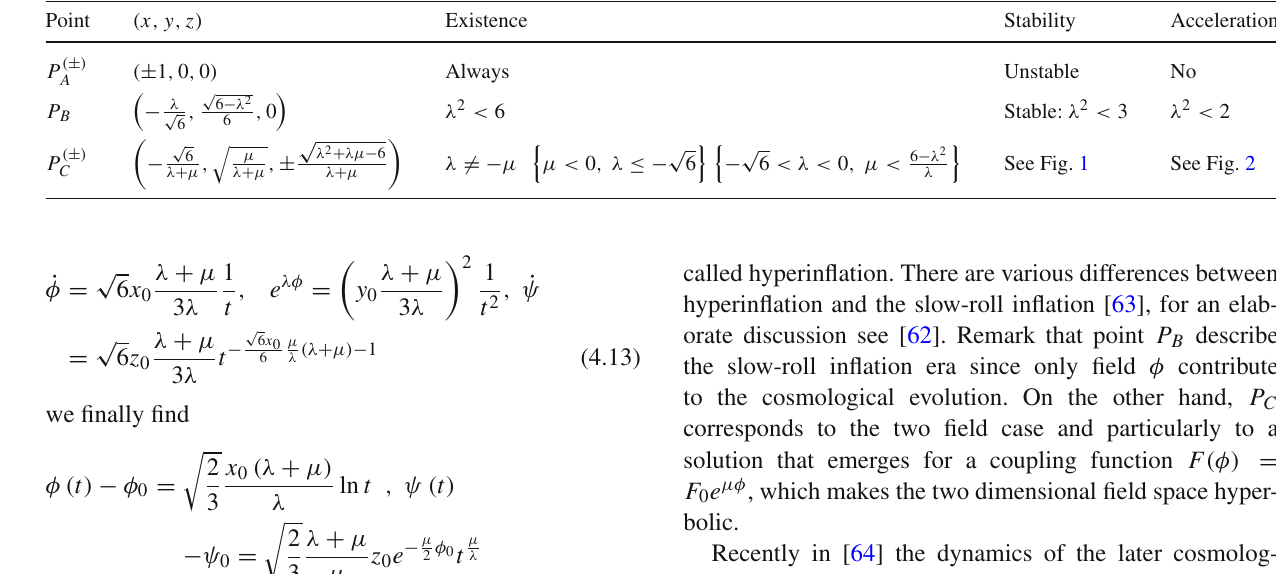
Fig. 2 Phase space diagram for the dynamical system (4.3)–(4.5) for two different set of the free parameters λ and μ . Left figure is for (λ,μ) = (λ,μ) = ( − 3 , − 4 ) and points P ± ( − 1 , 2 ) where point P are the attractors of the dynamical system B is the unique attractor while right figure is for C Table 2 Critical points of the dynamical